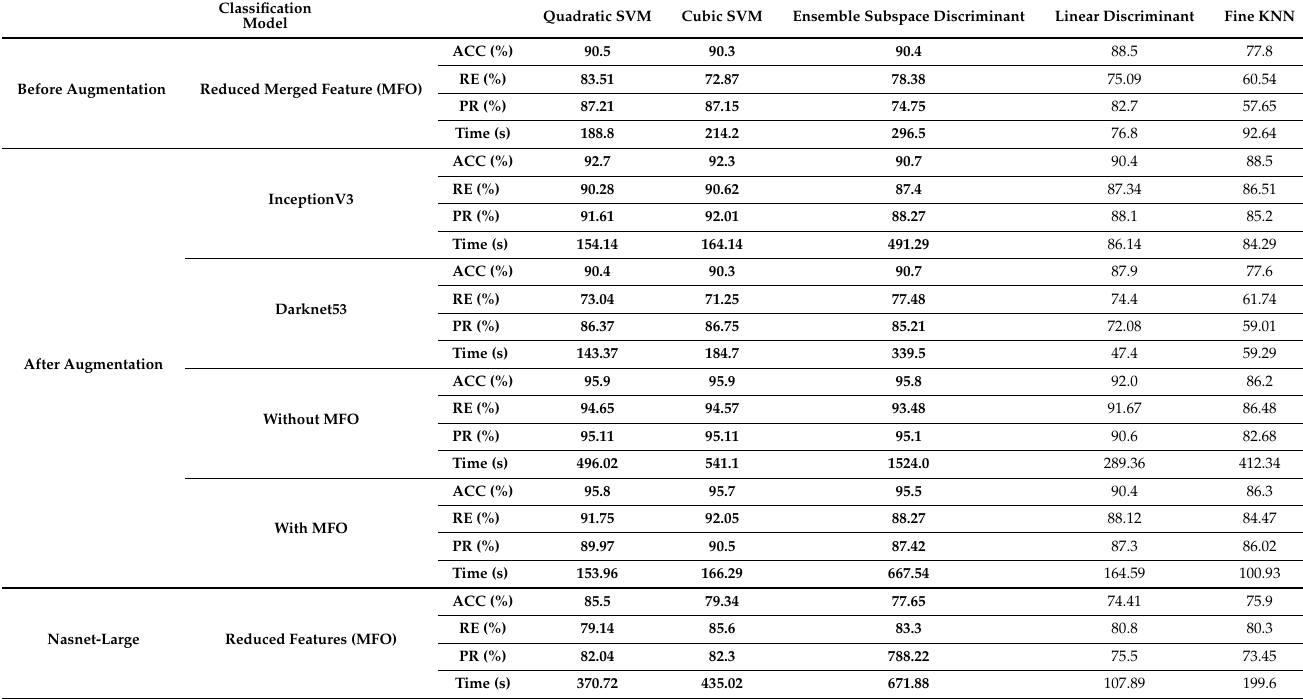
Table 2. Classification